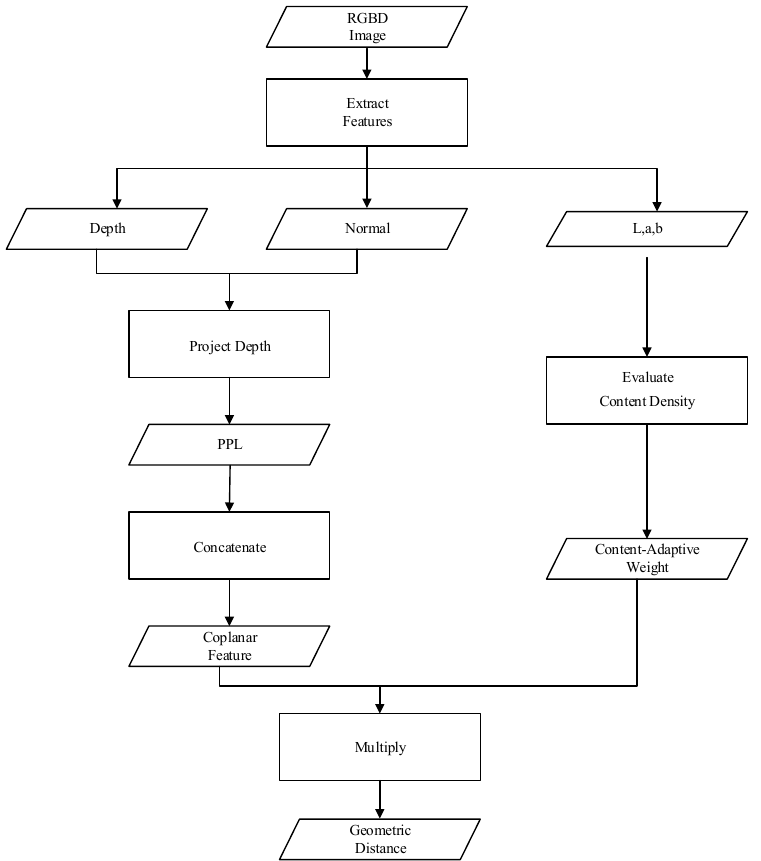
Figure 2. Workflow of the geometric distance computation. Color, normal and depth maps are extracted from RGBD images. The normal and depth maps are used to generate the plane projection length (PPL), and the color map is used to evaluate the content-adaptive weight. Furthermore, the coplanar feature is concatenated by the lab and the PPL. Finally, the geometric distance is produced by multiplying the content-adaptive weight and the coplanar